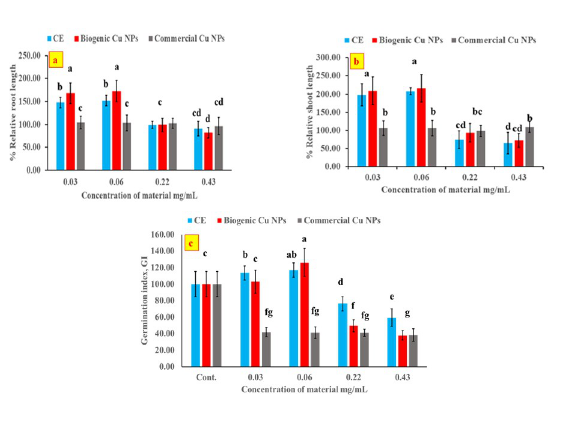
Fig 6. Effect of CE, biogenic and commercial Cu NPs on % relative growth of root (a) and shoot lengths (b) and germination index of wheat seeds (c).